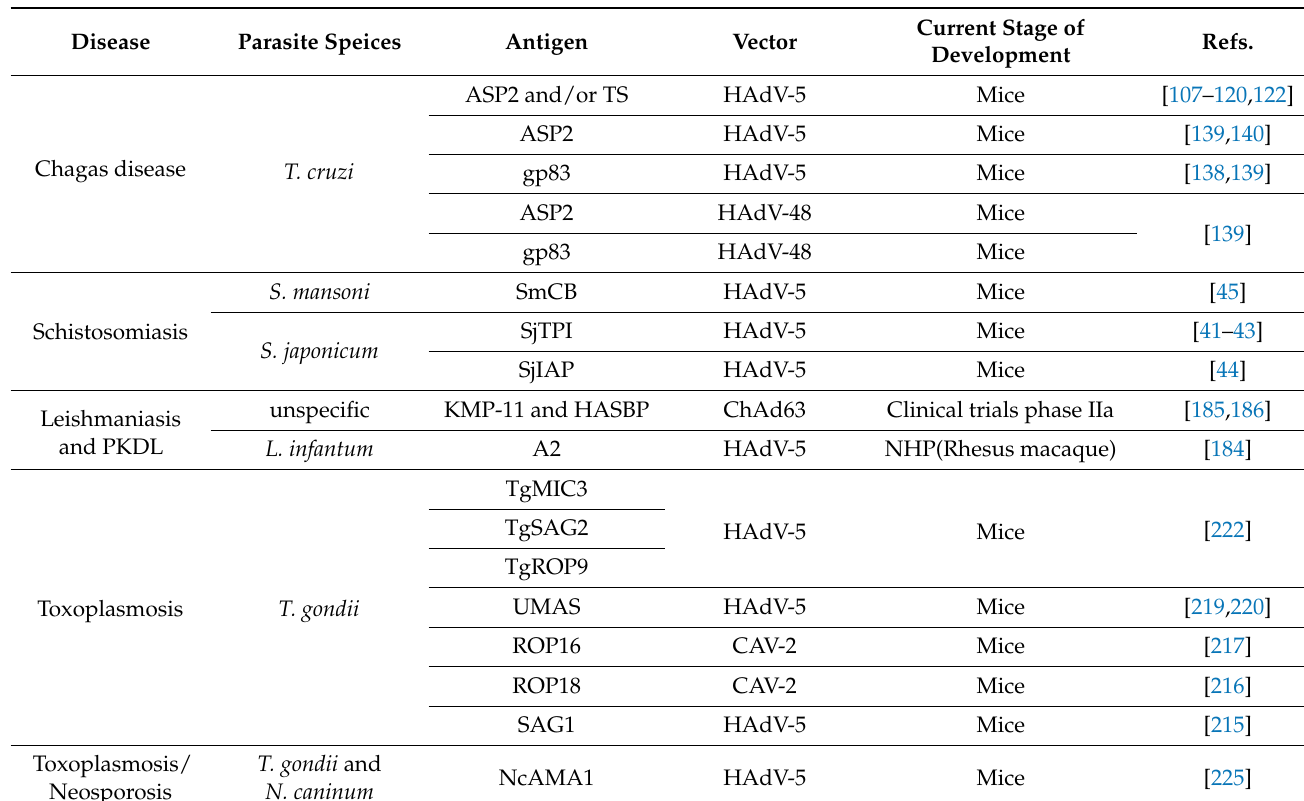
Table 4. Notable parasite AdV-vectored vaccines in pre-clinical and clinical trials (malaria excluded). This table is non-exhaustive. For summaries of AdV-vectored vaccines for malaria, see